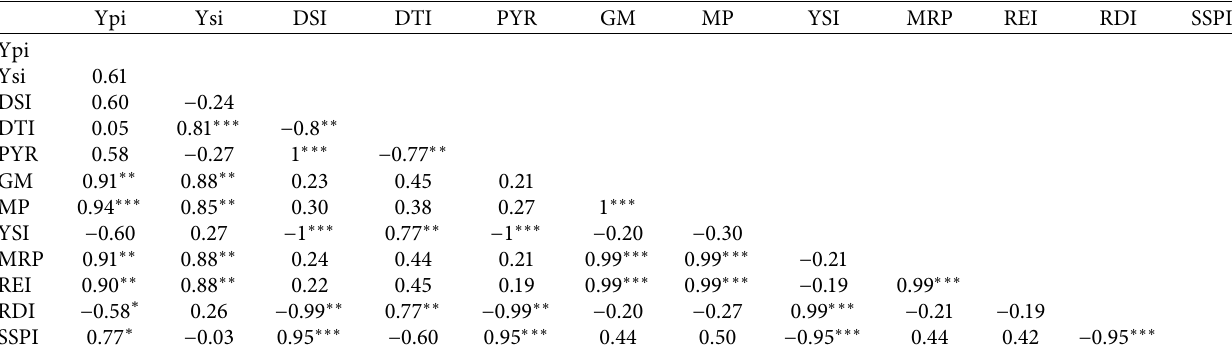
Table 6: Simple correlation analysis among drought tolerance indices affected by drought stress at pod setting